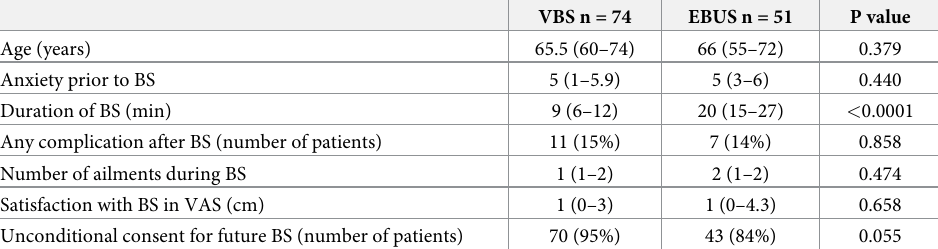
Table 1. Differences between different types of bronchoscopy procedures.